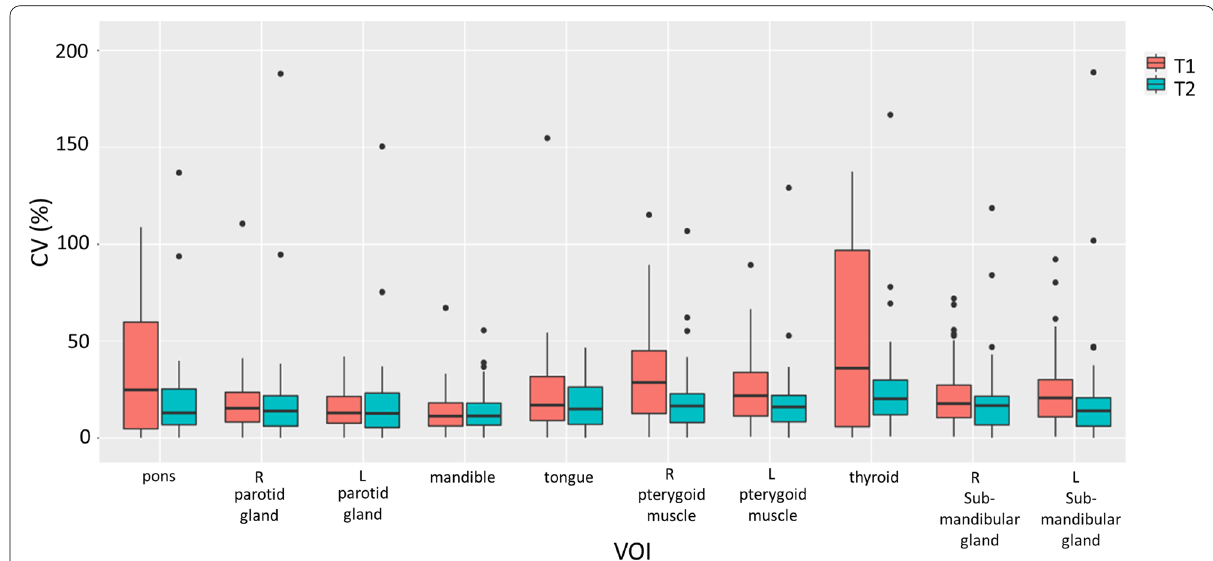
Fig. 7 Boxplots of the feature CV intra-subject values in different tissue VOIs for both pulse